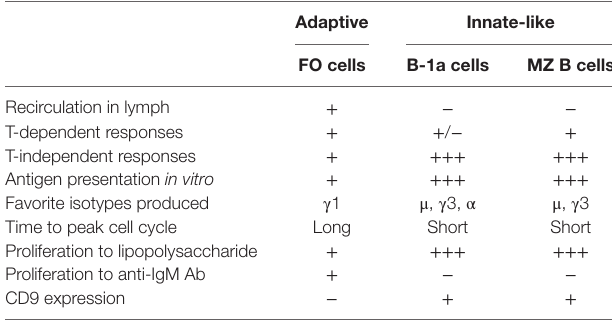
TABLe 2 | Functional dichotomy in B cell